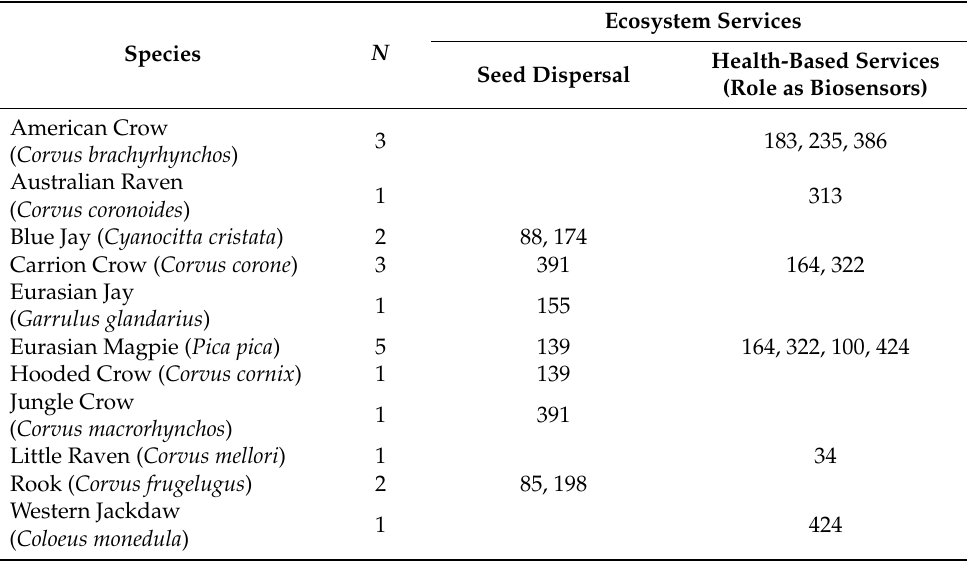
Table 12. List of articles reporting on ecosystem services provided by urban corvids ( n = 16). The reference numbers in the table refer to the individual publication numbers given in Table